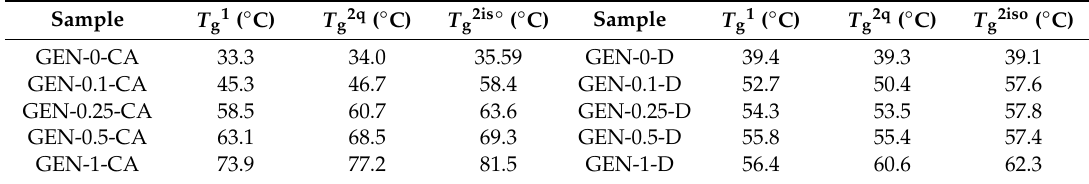
Table 3. Summary of Tg based on the measurement method and GNP content.